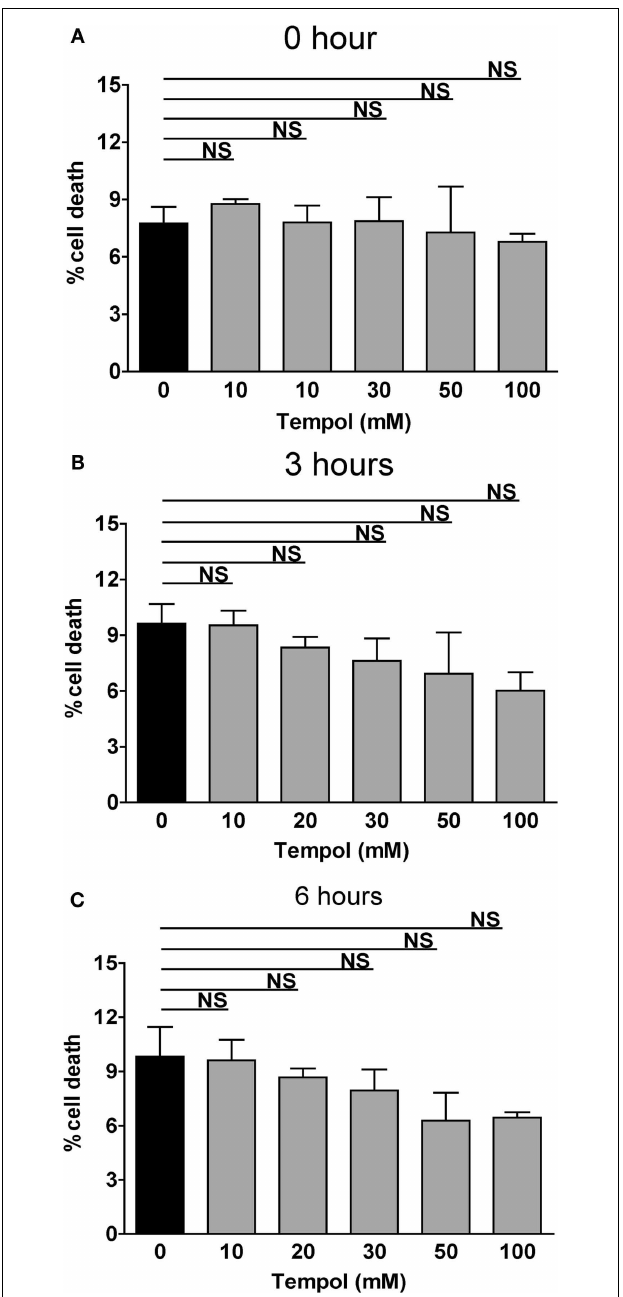
FIGUREA1 |Tempol alone is not toxic to human neutrophils. The rate of cell death of PMNs stimulated withTempol was analyzed over a period of 6h by measurement of DNA-staining by the cell-impermeable dye Sytox Green.The Y -axis represents the relative amount of dead cells after normalization to the lysis control (100%). PMNs treated withTempol in a dose-dependent manner at time point 0 (A) , after 3h (B) , and after 6h (C) . Black bars: unstimulated PMNs, gray bars: PMNs treated withTempol at different concentrations. Significance was analyzed byTukey one-way ANOVA (NS: P > 0.05). One representative experiment out of three independent experiments with three different donors is shown. Data are presented as means of three technical replicates ±